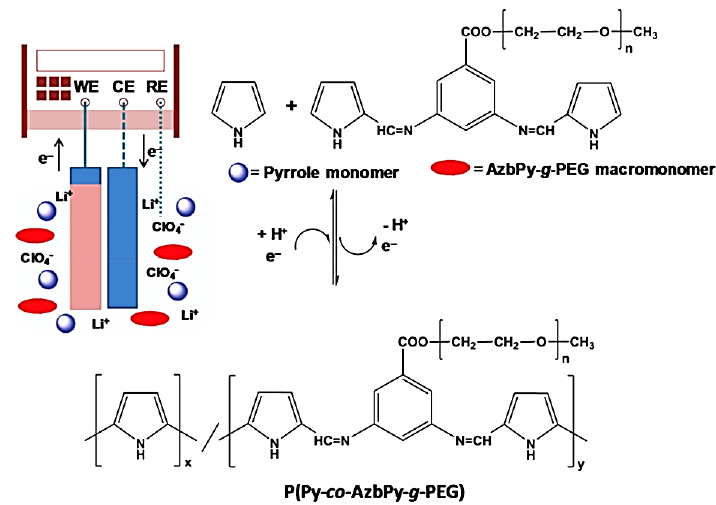
Figure 3. Scheme illustrating the anodic polymerization of P(Py– co –AzbPy– g –PEG). Reproduced with permission [50].